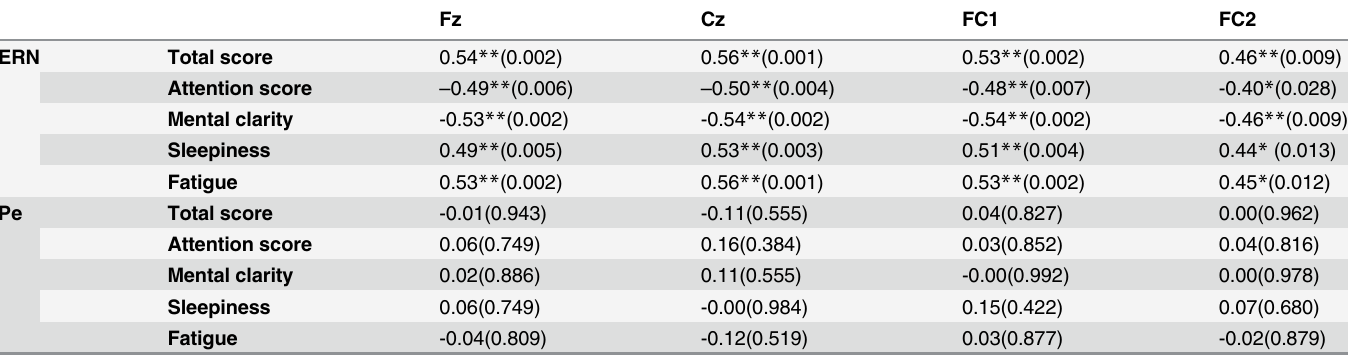
Table 4. Spearman correlations between questionnaire and error-related ERPs (mean amplitudes of ERN and Pe).